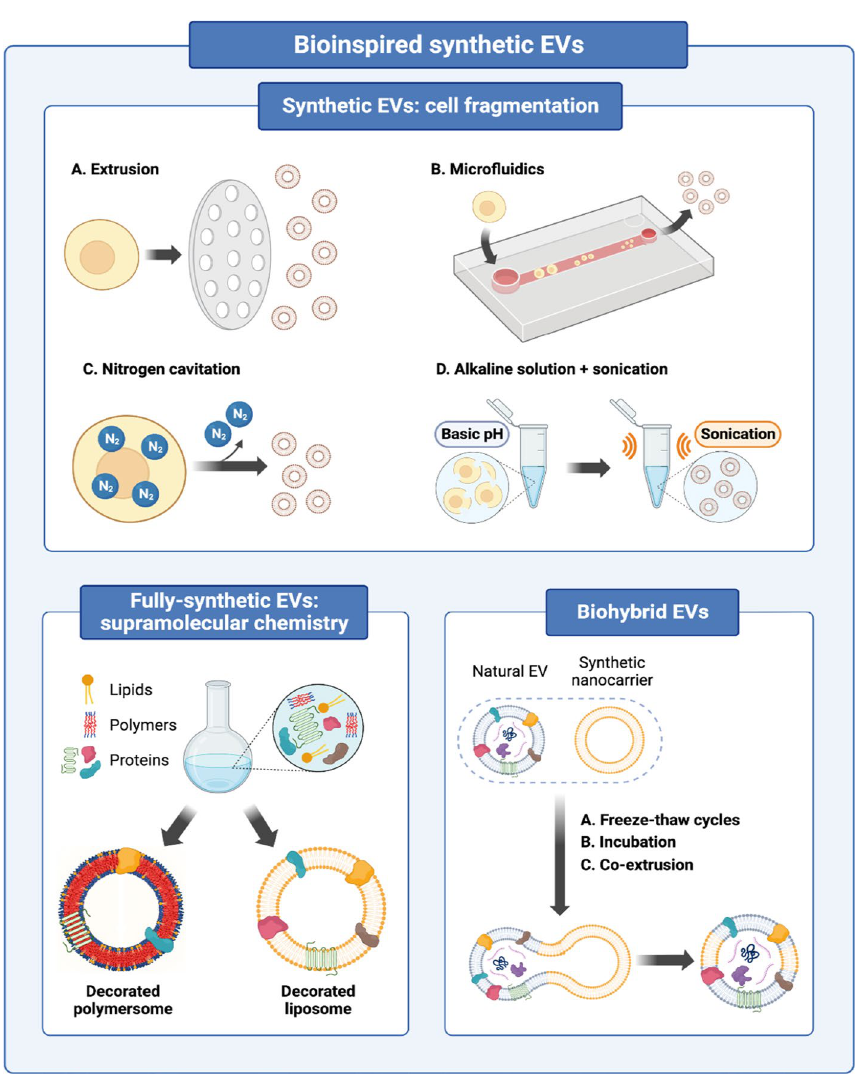
Fig. 3 Different approaches to obtain bioinspired synthetic EVs. Strategies based on cell fragmentation, supramolecular chemistry and biohybrid